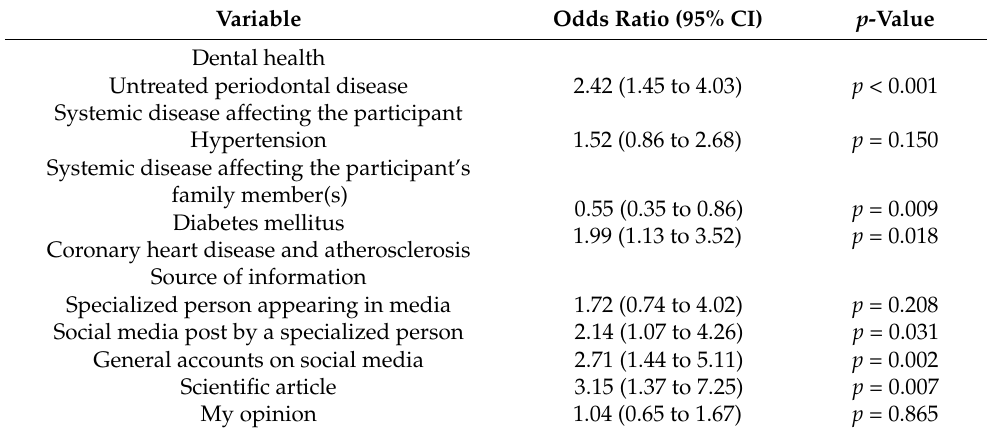
Table 13. Multivariate analysis for the association between periodontal disease and hypertension.